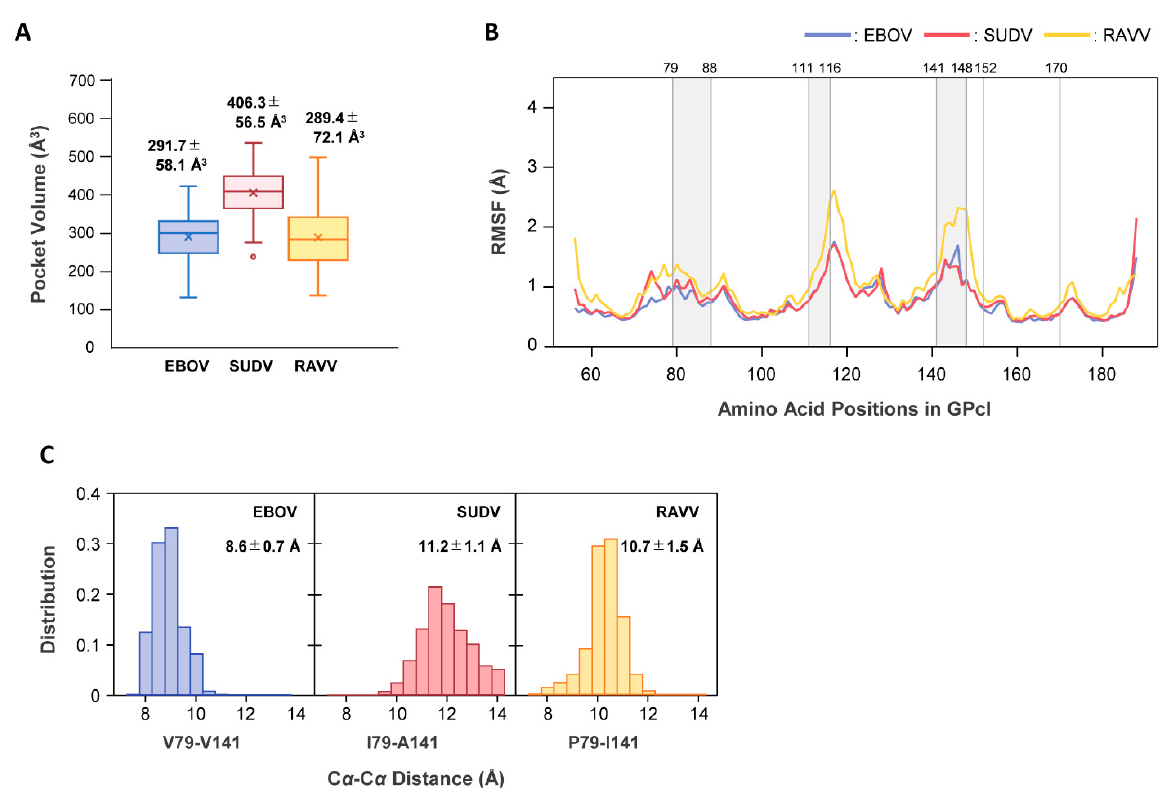
Figure 6. MD simulations for free GPcl molecules of EBOV, SUDV, and RAVV. ( A ) The volumes of the receptor-binding pocket in the free GPcl molecules of EBOV (blue), SUDV (red), and RAVV (yellow) were calculated with the POVME 3.0 program. The values in the plot area represent the mean and standard deviation (SD) of the pocket volumes from each monomer in the GPcl trimer. In each box plot, the mean and median values are indicated by “x” and a solid horizontal bar, respectively. The top and bottom edges of the box mark the first and third quartile, respectively. Outliers, shown as open circles, are cases with values more than 1.5 times the interquartile range away from the upper or lower quartile. The whiskers extending from the box indicate the highest and lowest values, excluding the outliers. ( B ) RMSF values were plotted for free EBOV (blue), SUDV (red), and RAVV (orange) GPcl structures. Gray regions between the numbers above the plot area represent the constituent residues of the receptor binding pocket. ( C ) The C α− C α distances (Å) of V79–V141, I79–A141, and P79–I141 were measured for each monomer in the GPcl trimers of EBOV, SUDV, and RAVV, respectively. Distributions of the C α distances during MD simulations are shown for EBOV (blue), SUDV (red), and RAVV (orange) GPcl molecules. The average distance and SD are indicated in each panel. A total of 1500 snapshots from each trajectory of the last 50 ns were used for all the analyses ( A – C ).